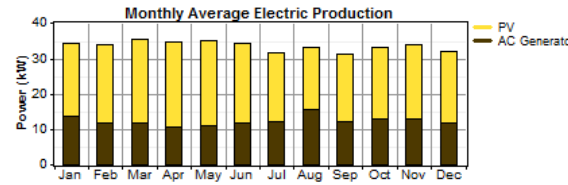
Figure 13: Monthly Average Electric Production for Kano